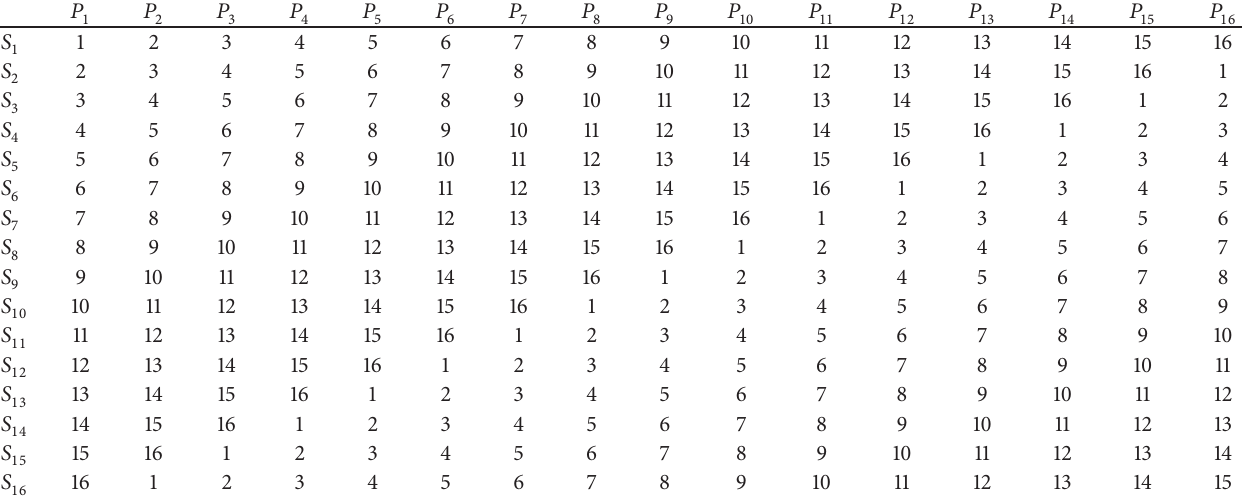
Table 2: The 16 arrangements of the PPTs designed for data collection.